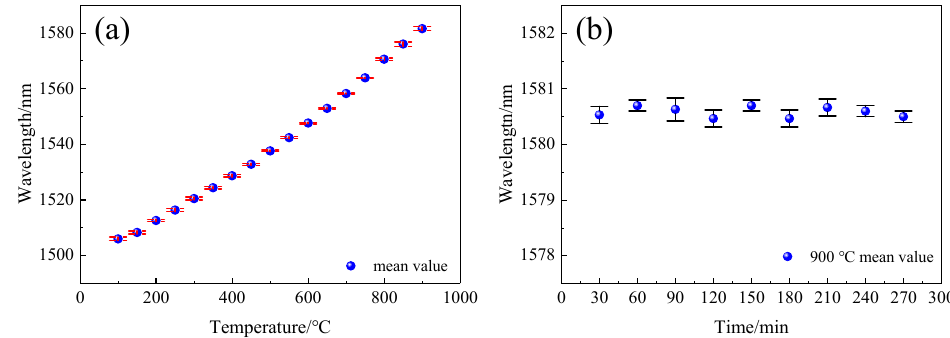
Figure 19. ( a ) Mean and standard deviation of the temperature dependence of the 1506 nm dip; ( b ) Mean and standard deviation of the 1506 nm dip at 900 °C. Many scholars have made contributions to the research of fiber temperature sensors.